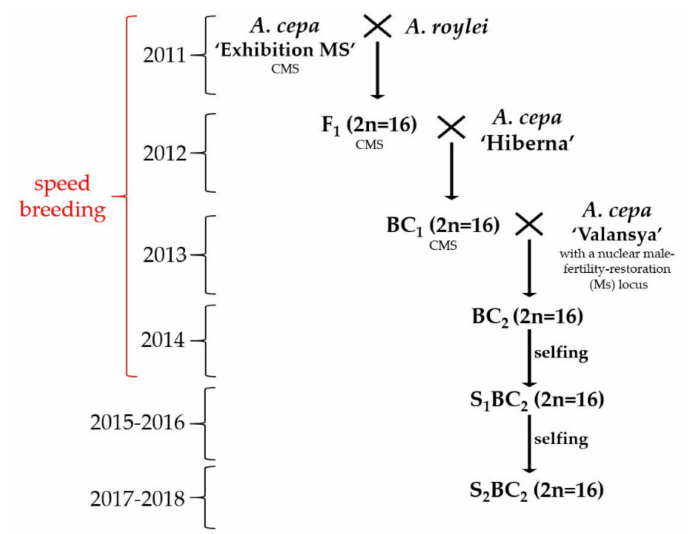
Figure 5. The scheme of interspecific breeding of bulb onion resistant to downy mildew. ‘Speed breeding’: using prolonged photoperiod and vernalization for obtain of mature seeds in one year. CMS: cytoplasmic mail